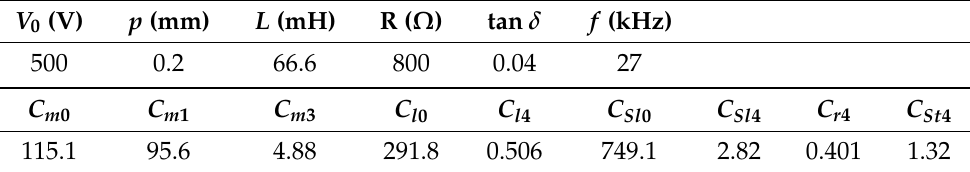
Table 2. Parameters used for calculations of model outputs. Capacitance values expressed in